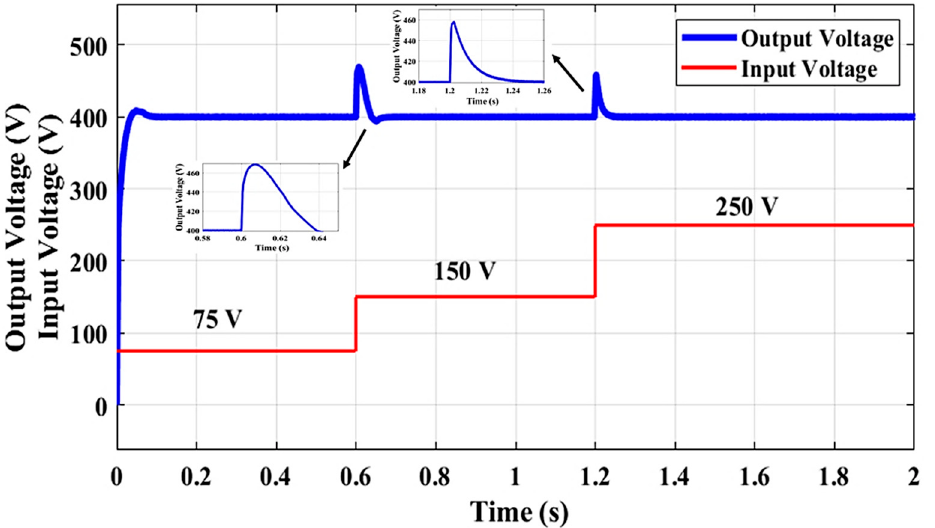
Figure 13. Output voltage response with input voltage variation for proposed HG-SIQBC.